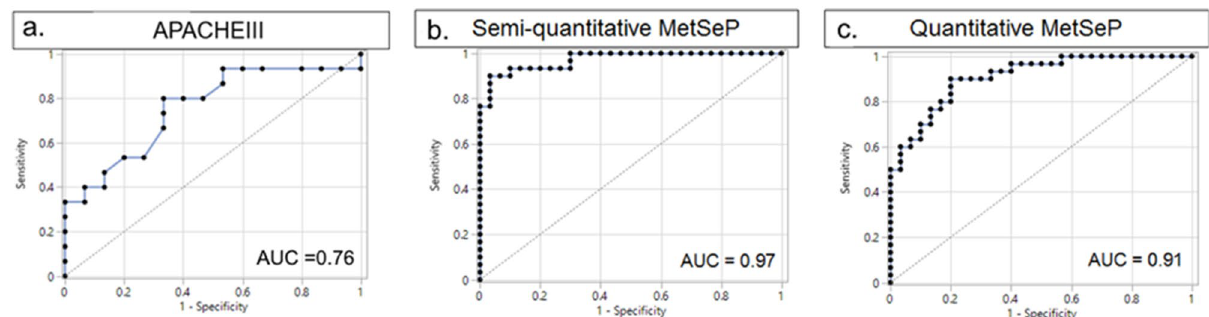
Figure 5. AUROC analysis of lactate and MetSeP score. APACHEIII was measured in the TARGET patients at ICU admittance. MetSeP was measured using semiquantitative results from Metabolon and quantitative analyses. Logistic regression shows that APACHEIII values were less accurate (area under the curve; AUC = 0.76) for patient outcome prediction than MetSeP scores (AUC = 0.97 and 0.91, respectively). Figures made utilizing JMP Genomics 8.0, https:// www. jmp. com/ en_ us/ softw are/ genom ics- data- analy sis- softw are.